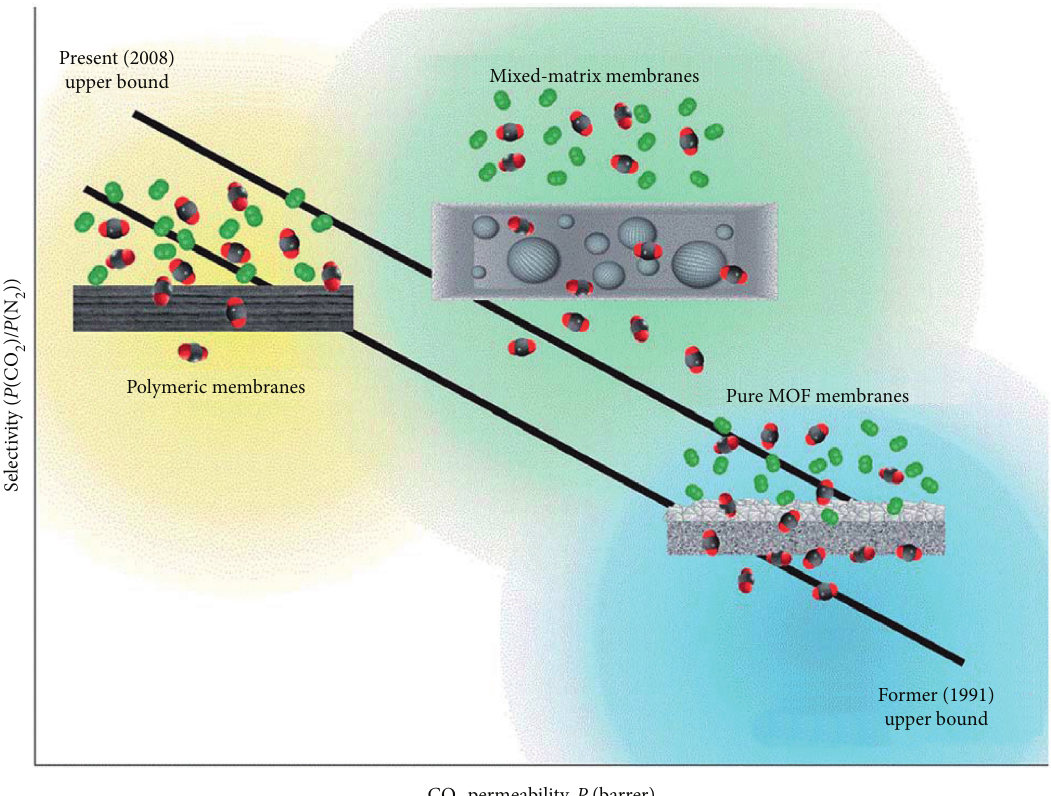
Figure 2: Comparison between selectivity and permeability for CO membranes [6,